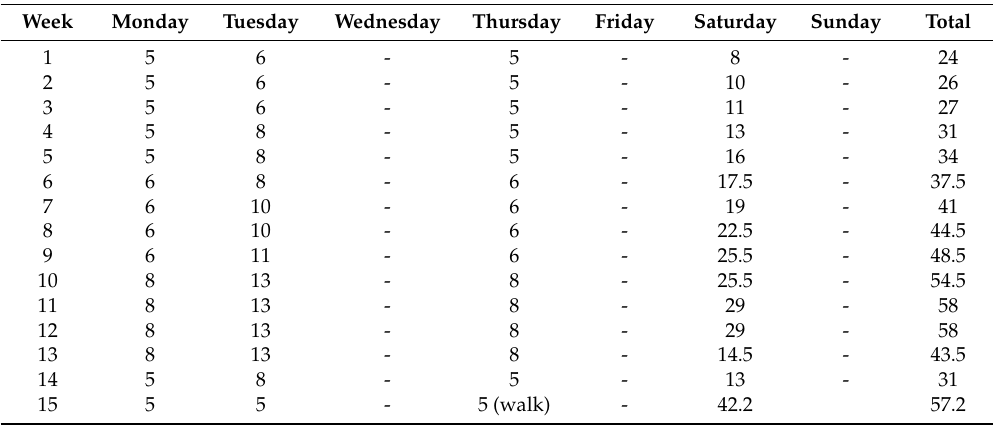
Table 1. Marathon Training Program Showing Distance (km) Completed Per